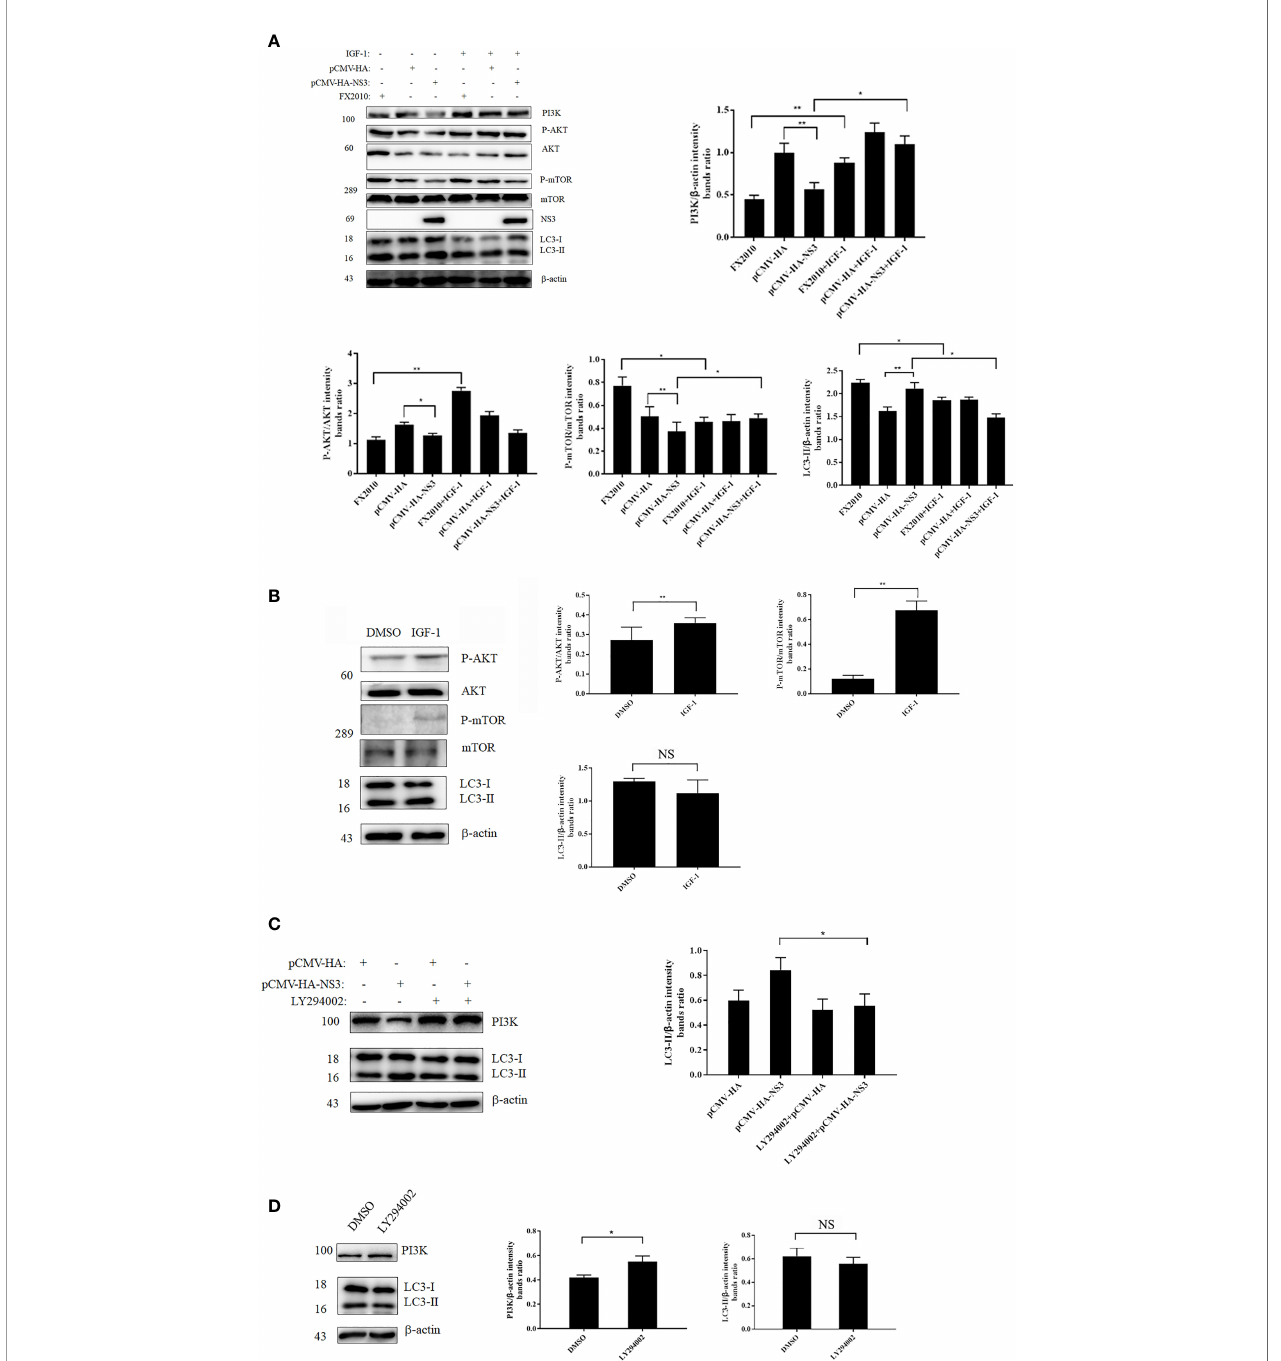
FIGURE 4 | NS3 induces autophagy by inhibiting the phosphorylation of PI3K-AKT-mTOR. (A) After 24 h of treatment with IGF-1, the pCMV-HA and pCMV-HA- NS3 plasmids were transfected into DEF cells respectively, and samples were collected at 24 hpt. In addition, DEF cells were infected by FX2010 (MOI = 0.1) and samples were collected at 24 hpi. (C) After 2 h of treatment with LY294002 (10 m M), the pCMV-HA and pCMV-HA-NS3 plasmids were transfected into DEF cells respectively, and samples were collected at 24 hpt. (B, D) After 24 h of treatment with DMSO or IGF-1 (diluted by DMSO; 50 m g/ml), or treatment with LY294002 for 2 h, samples were collected at the corresponding time. Proteins levels of PI3K, AKT, mTOR, and their phosphorylated proteins, as well as b -actin, were measured by Western blot. The density of the protein bands measured with fusion analysis in ImageJ software was determined after subtracting the density of the b -actin bands. The b -actin protein was used as the internal control. Data (M ± SD of technical triplicates) represent three independent experiments or are pooled from three independent experiments (M ± SD). * p < 0. 05; ** p < 0. 01; NS, no signi fi